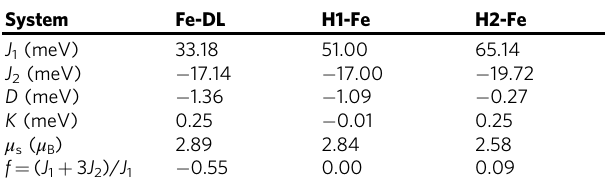
Table 1 Parameters used for the spin dynamics simulations System